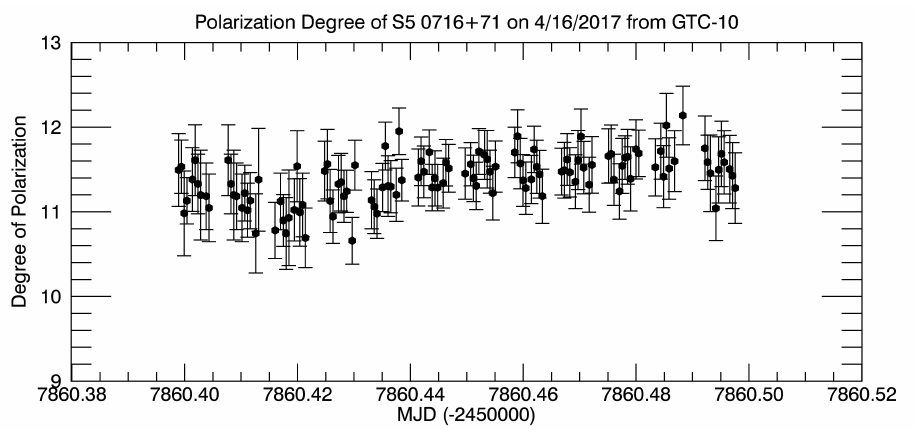
Figure 5. H-band polarization degree versus time showing possible increase with time.